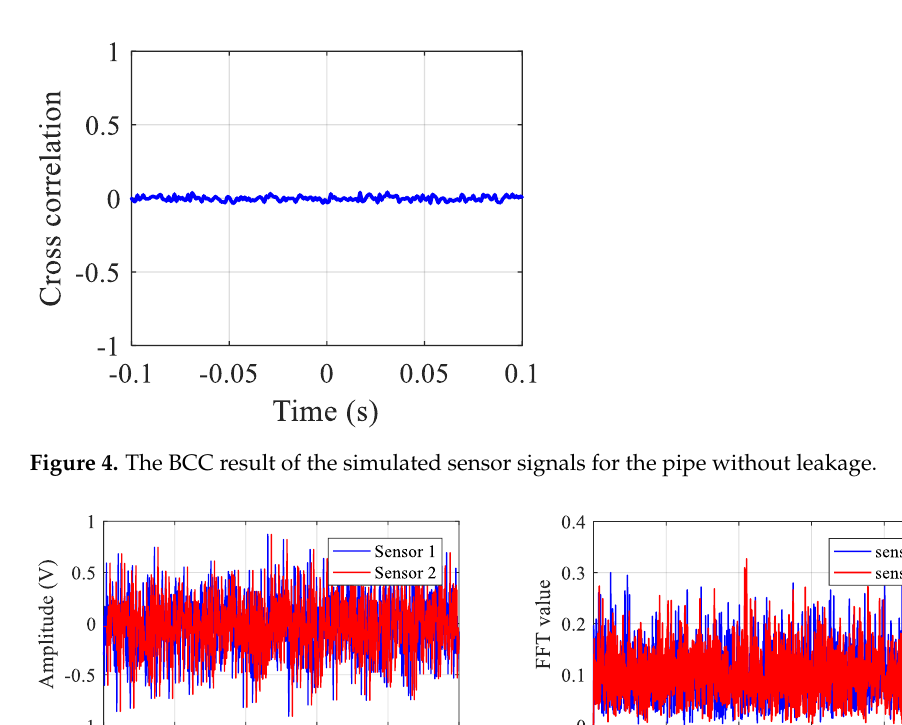
Figure 4. The BCC result of the simulated sensor signals for the pipe without leakage.